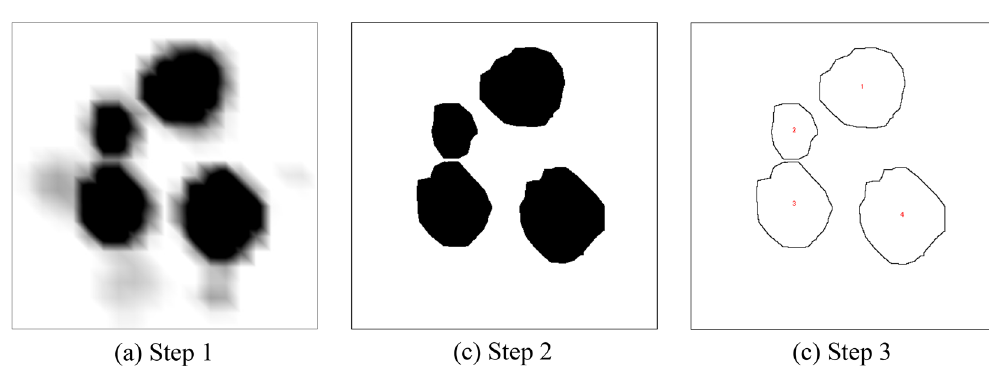
Figure 7. Image processing procedure for calculation of bubble